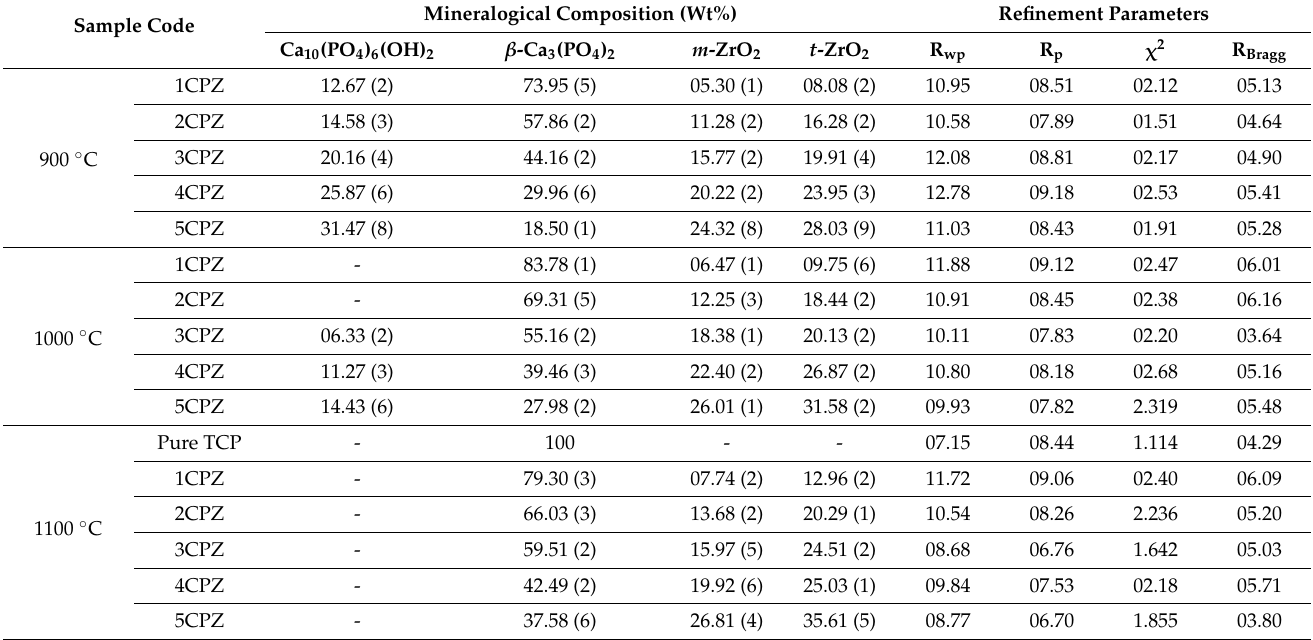
Table 2. Rietveld refinement agreement factors and phase composition data from the XRD pattern for three different temperatures.